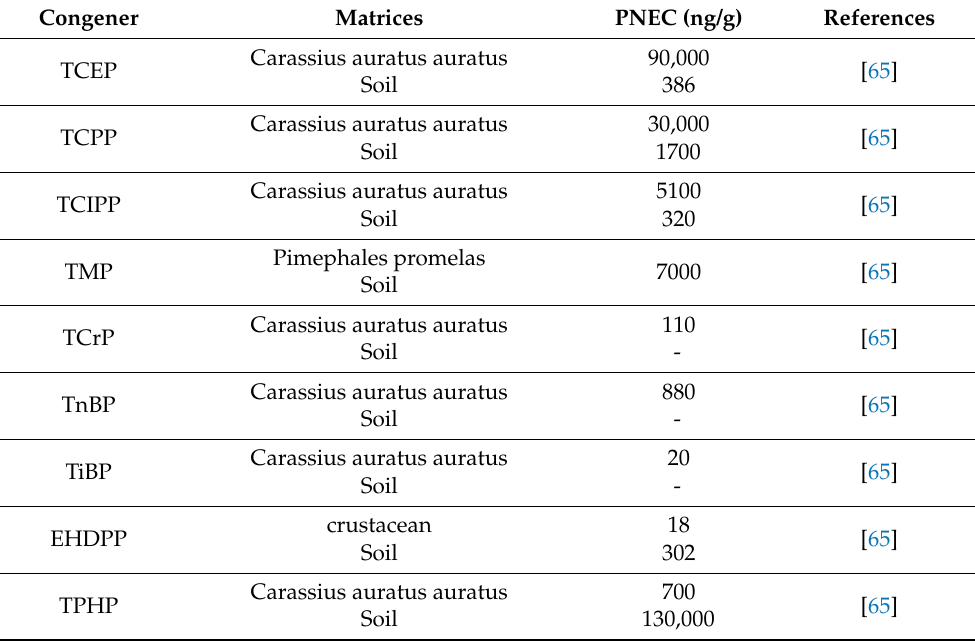
Table 3. Some OPFR congeners with PNEC (ng/g) from China in different matrices. Congener